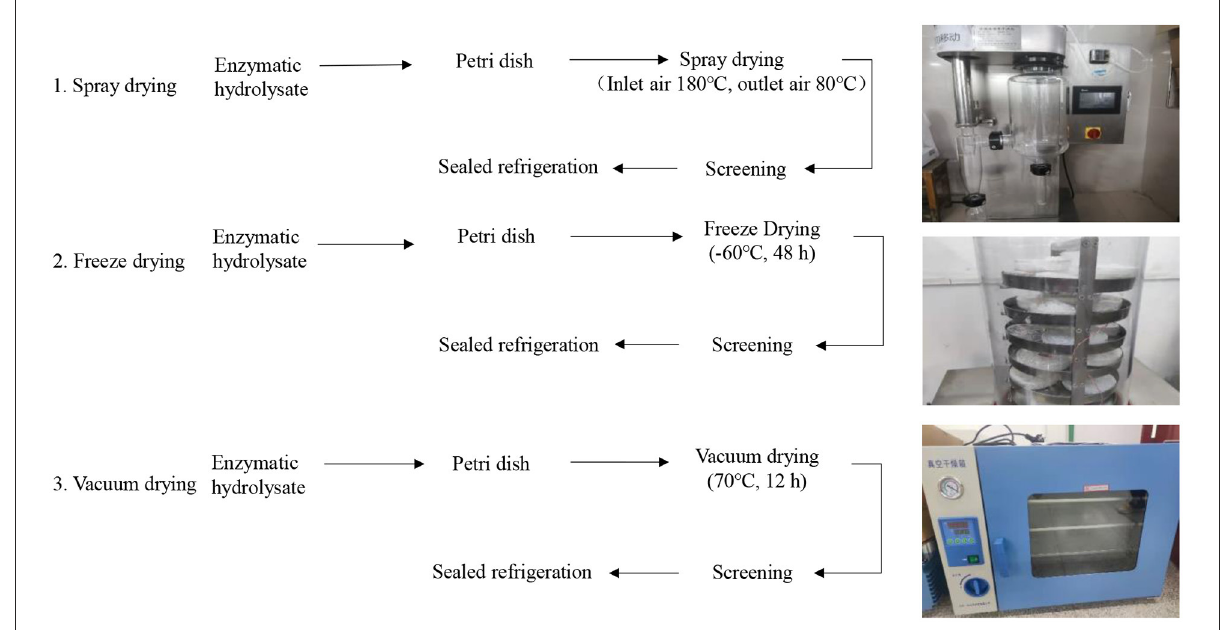
FIGURE1 Preparation process of protein peptide powder of salted duck egg white by three methods.